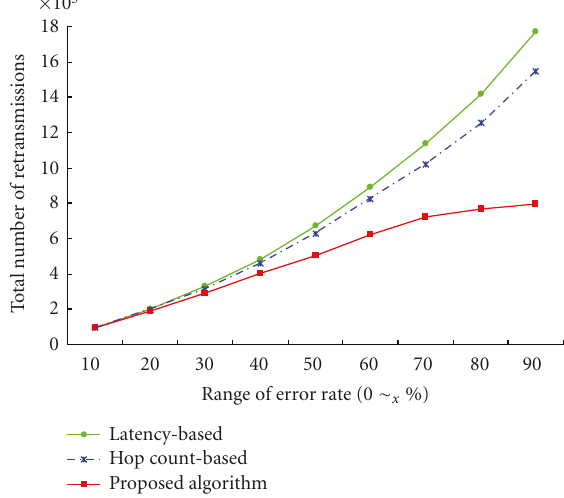
Figure 6: Event-to-sink reachability.